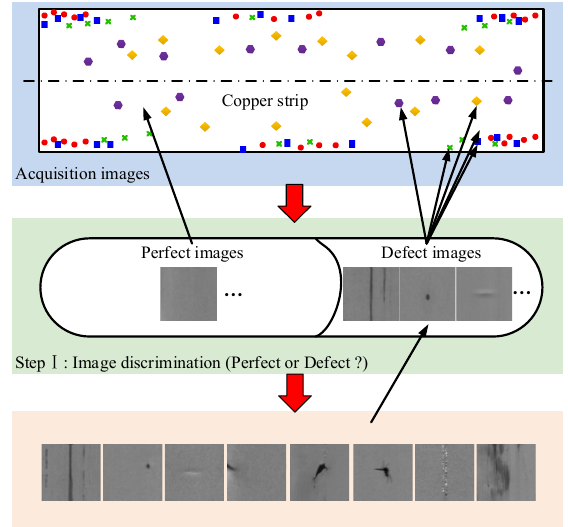
Figure 3. Surface defect detection model process.